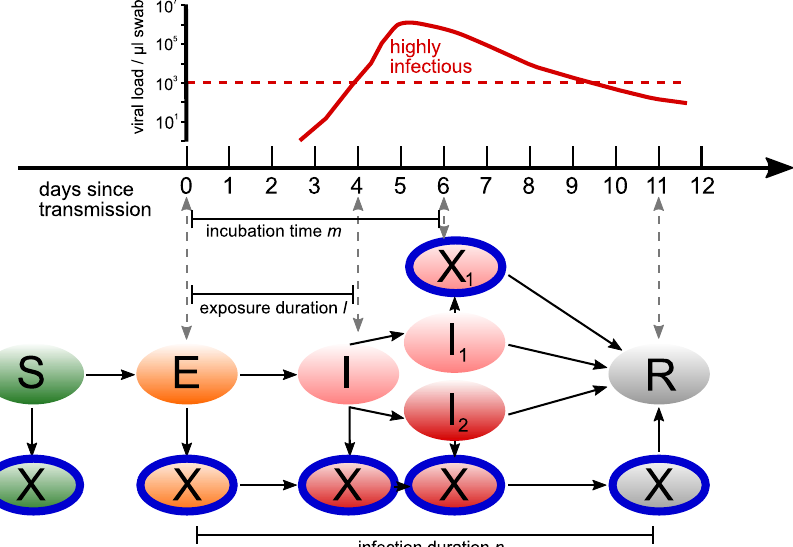
Fig. 6 Agents in the epidemiological model can be in the states (ellipses) susceptible (S), exposed (E), infectious (I), infectious without symptoms (I1), infectious with symptoms (I2) and recovered (R). Possible state transitions are shown by arrows. In each of these states, agents can also be quarantined (X), preventing them from interacting with other agents. Transitions between states follow the development of the viral load in the host sketched